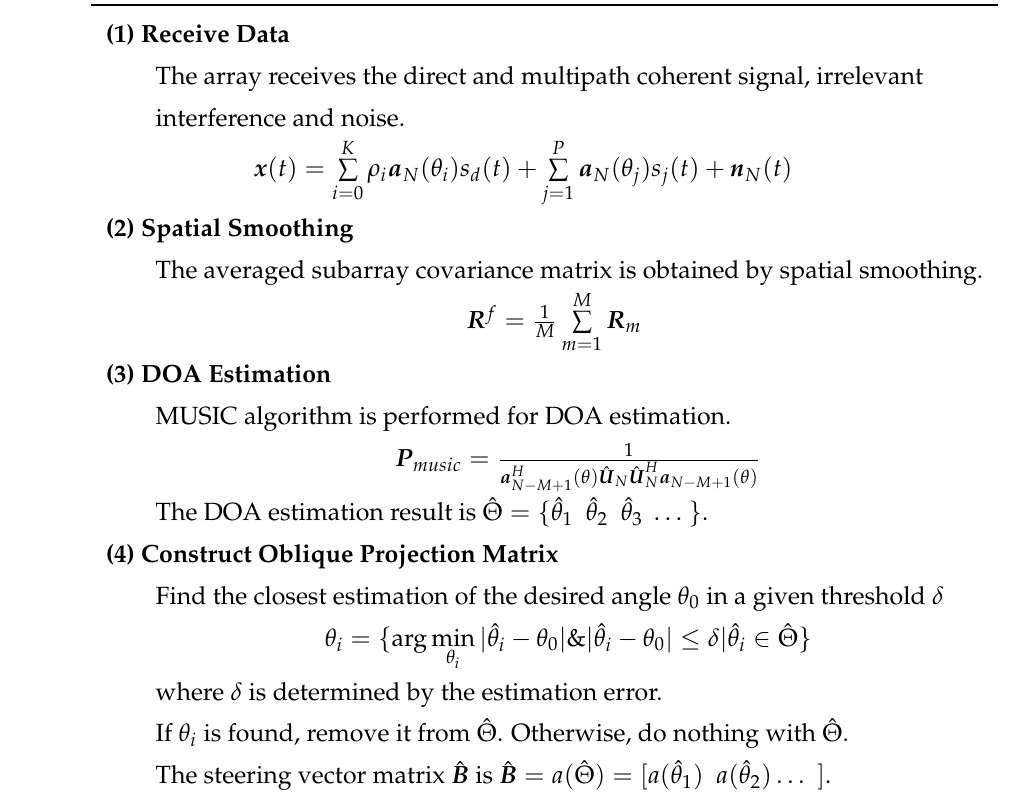
Table 1. The Flow of the Proposed